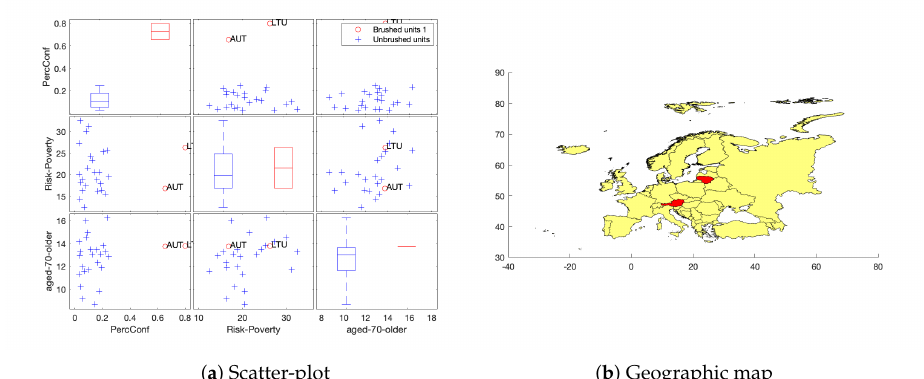
Figure 4. Exploratory step: Data brushing on multiple scatter-plot and box-plots to highlight countries on a map: points highlighted on scatter-plots are colored in red on the map. Wave 1.